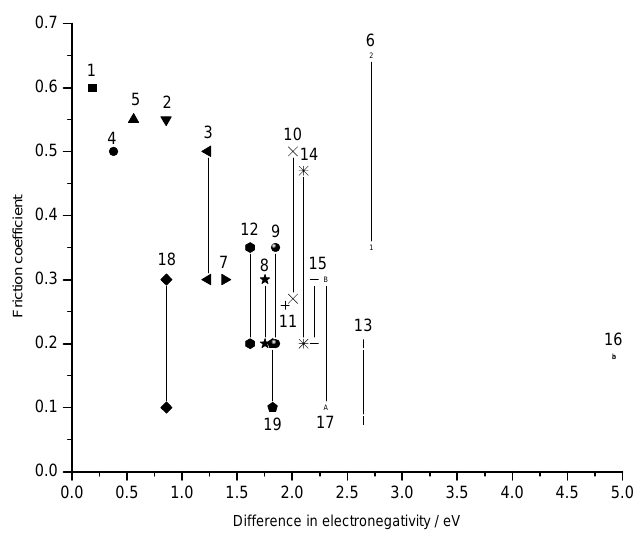
Figure 9. Relationship between friction coefficients and differences in electronegativity of certain solid oxide pairs with coordination number of 6.(Numbers next to data points correspond to the num- bers used in Table 3 for each oxide pair; data of friction coefficient of solid oxides are from Ref.